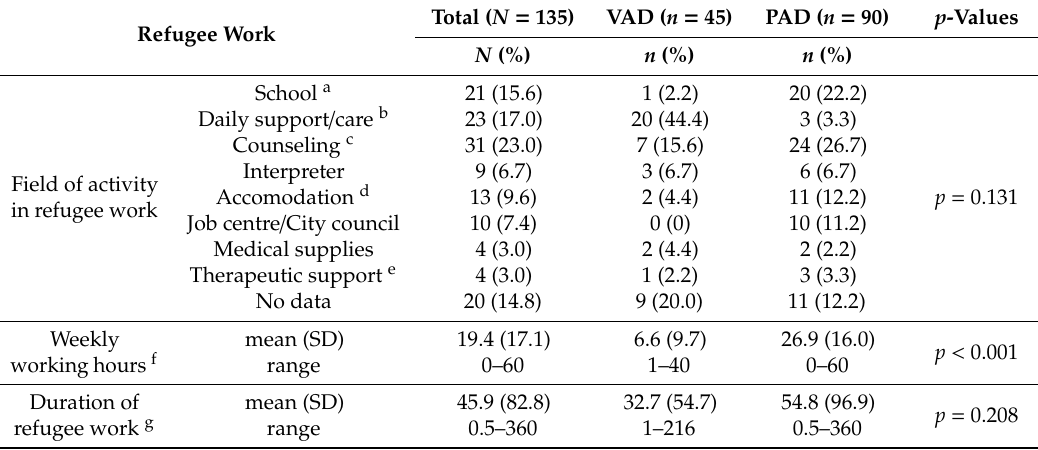
Table 2. Information on refugee work of the study sample.